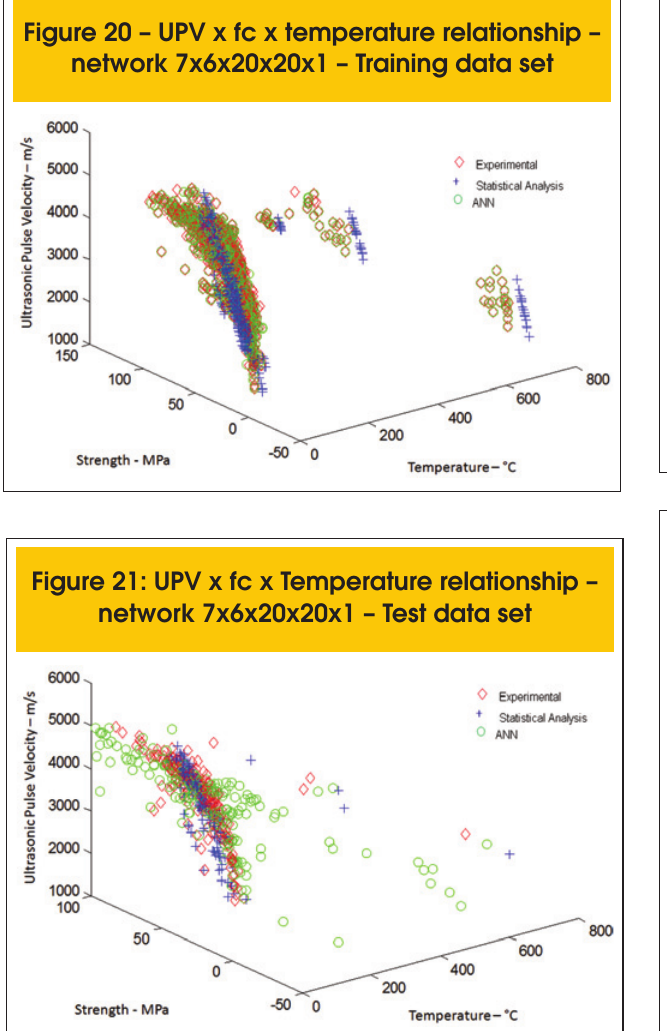
Figure 20 – UPV x fc x temperature relationship – network 7x6x20x20x1 – Training data set